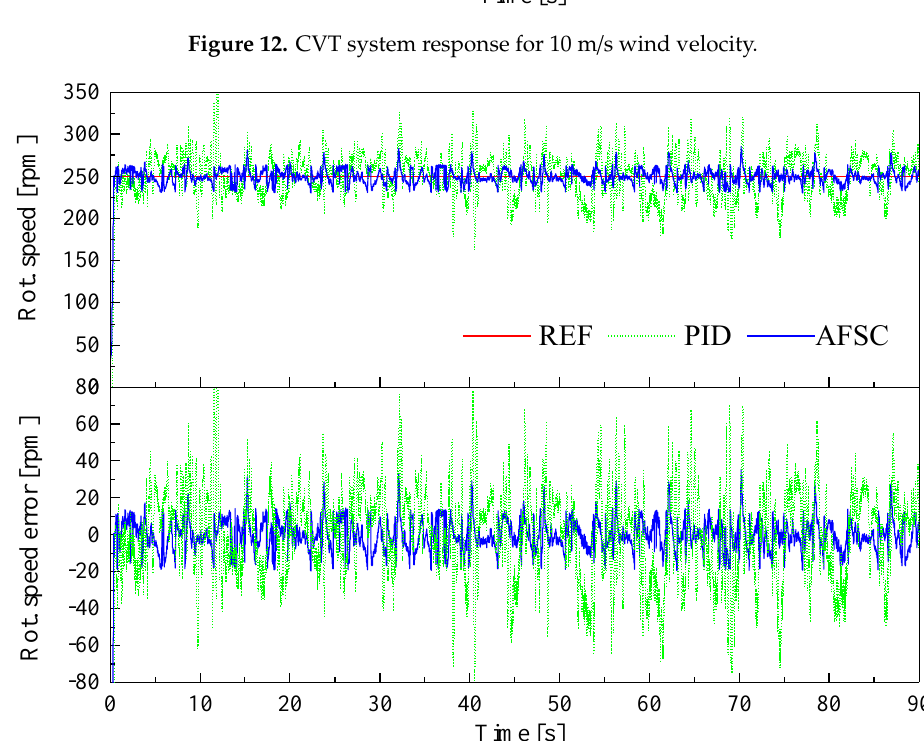
Figure 13. Comparison between convention PID and proposed AFSC.